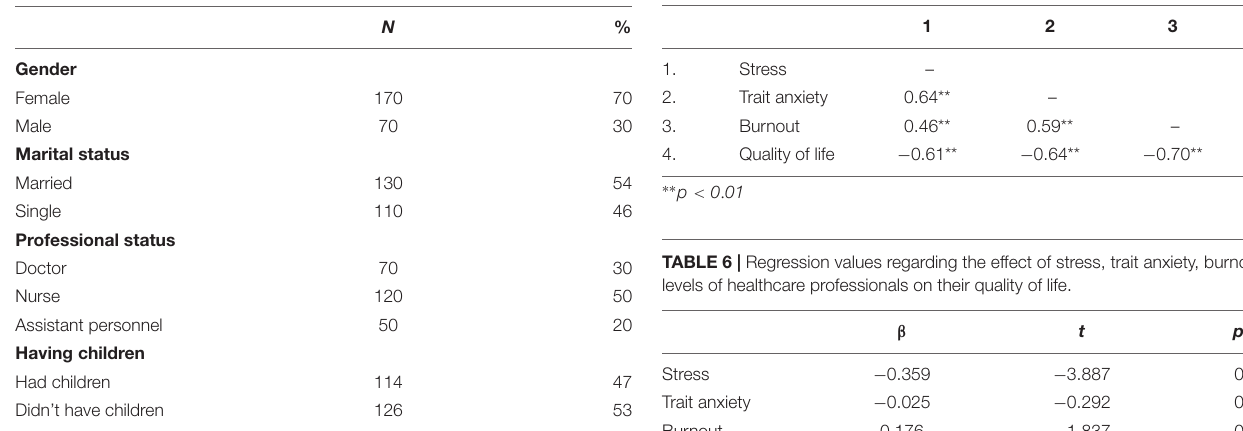
TABLE 3 | Sociodemographic characteristics of the healthcare professionals participating in the study.